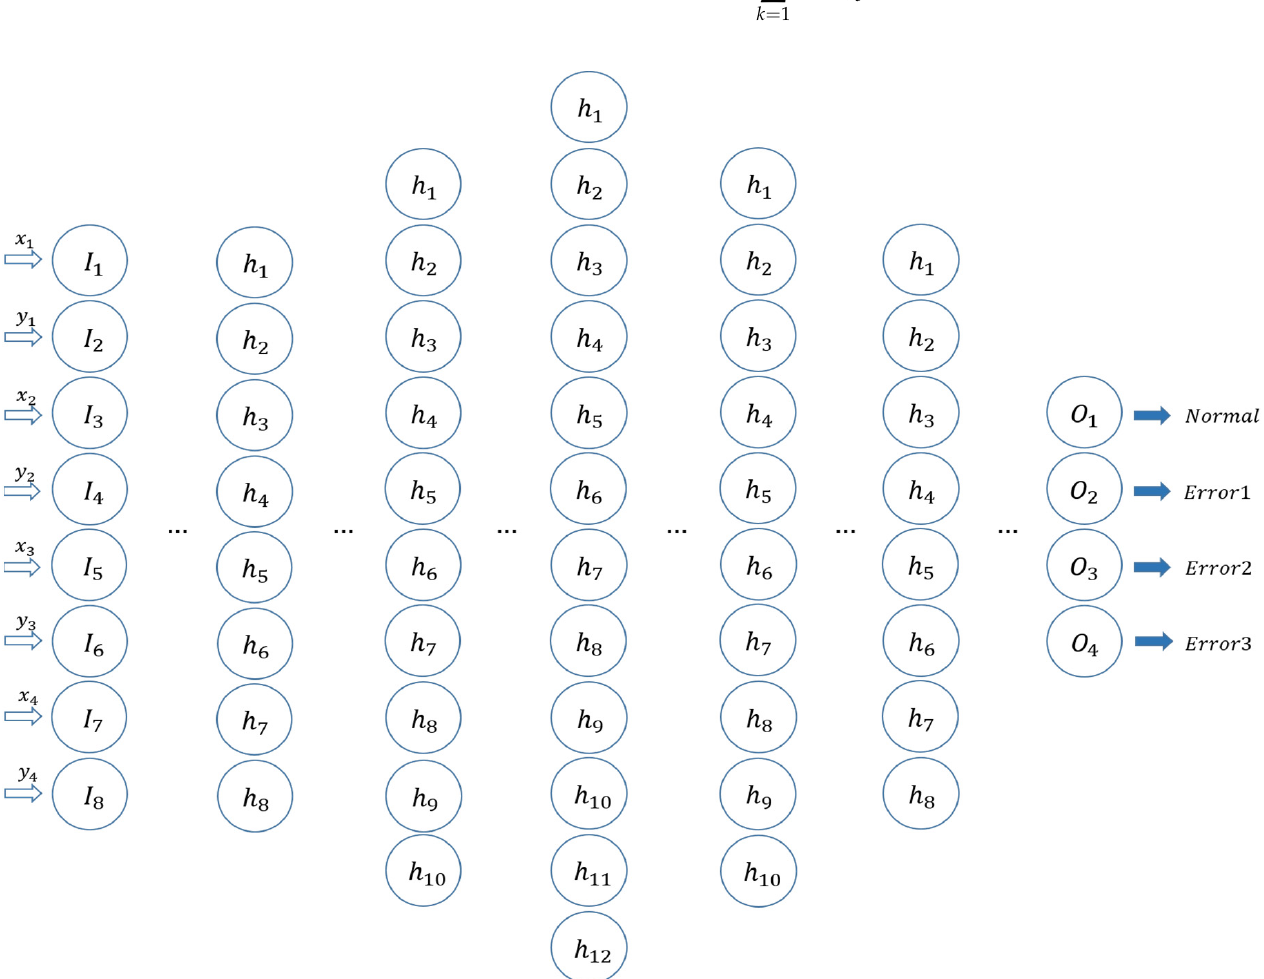
Figure 10. Neural network structure.